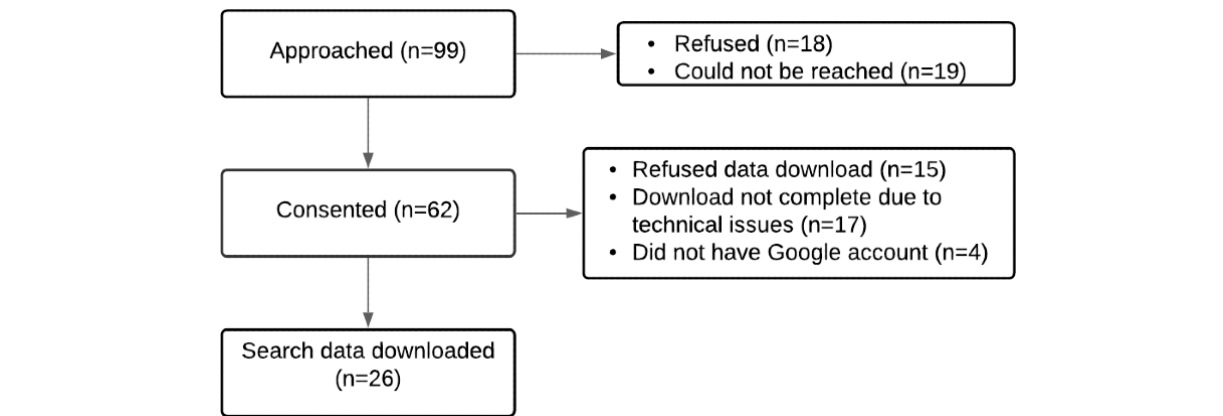
Figure 1. Study CONSORT flow